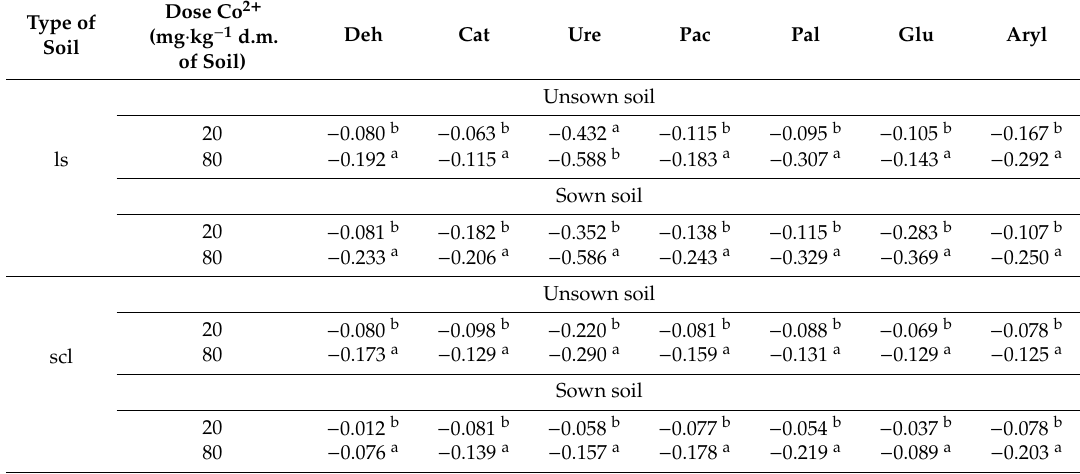
Table 10. Index of cobalt e ff ect ( IF Co ) on the enzyme activity.